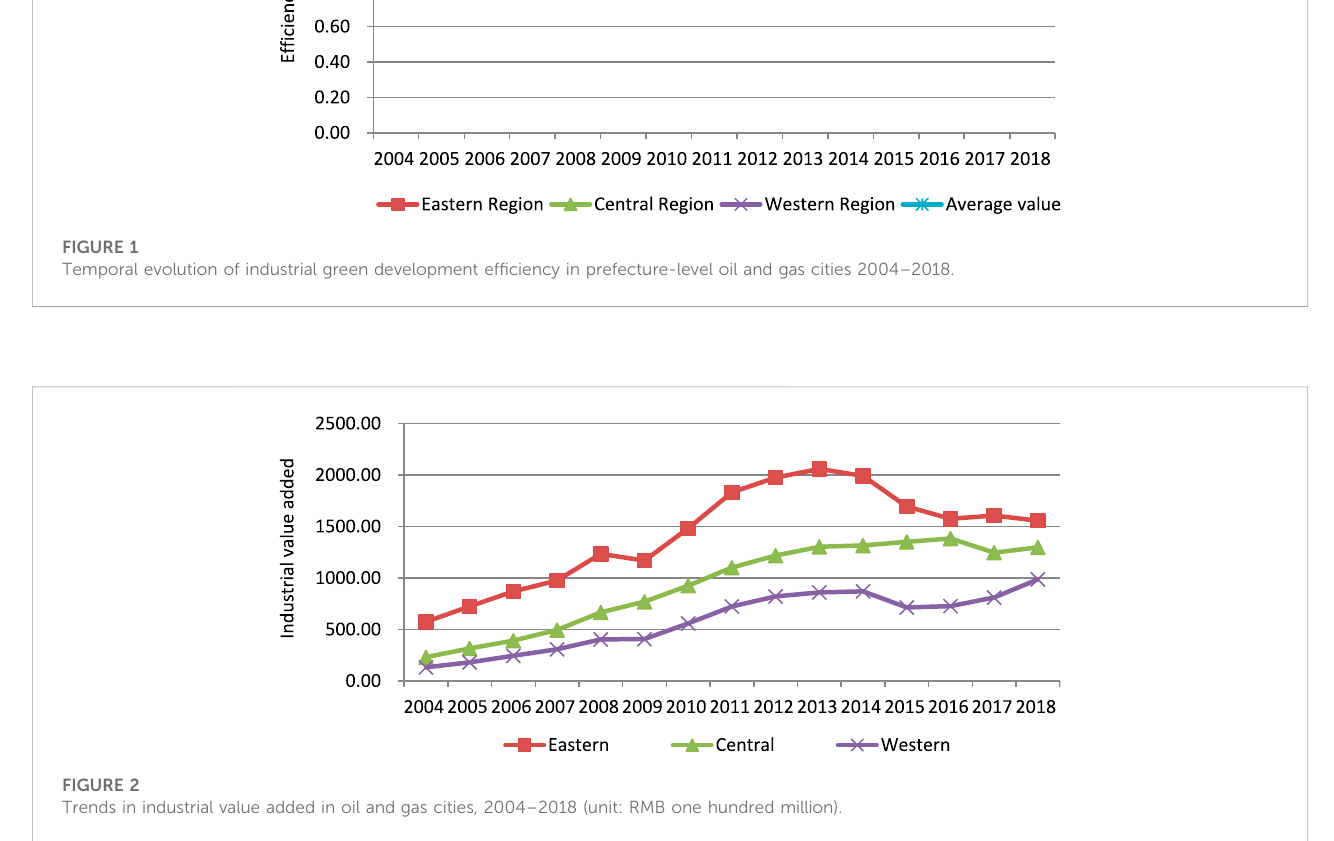
FIGURE 3 Trends in industrial energy consumption in oil and gas cities, 2004 – 2018 (unit: ten thousand tons of coal equivalent).